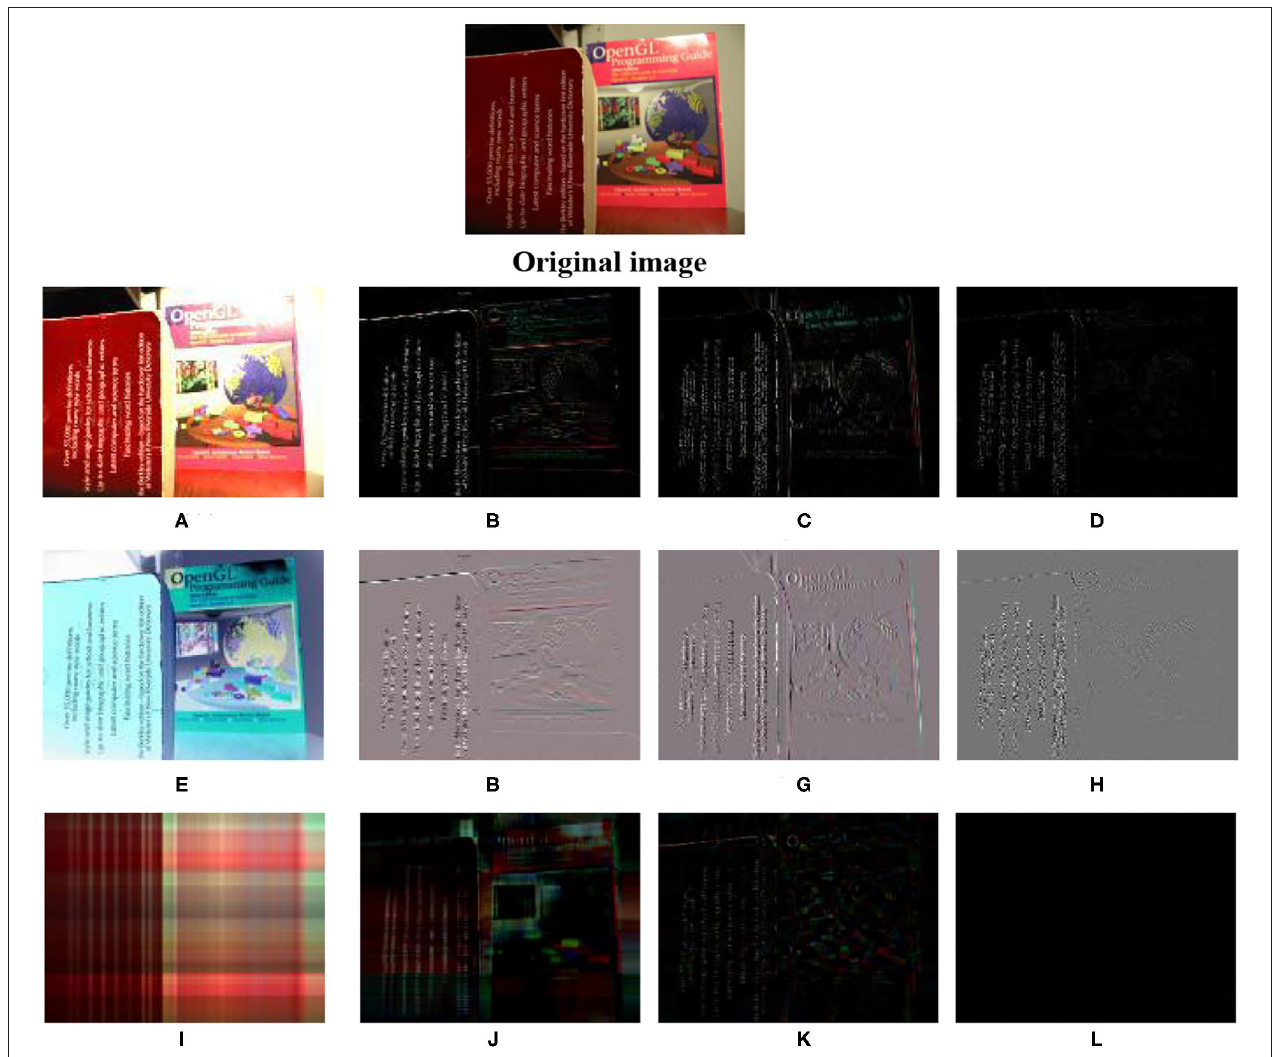
FIGURE 1 | This figure shows the decomposition of color image by QMSVD, MSVD, and QSVD. (A) The low-frequency image of the origianl image after decomposed by QMSVD, and (B–D) the high-frequency images of the origianl image. (E) The low-frequency image of the original image after decomposed by MSVD, and (F–H) the high-frequency images of the original image. (I) The decomposition image corresponding to the first eigenvalue of the original image decomposed by QSVD, and (J) the decomposition image corresponding to the eigenvalue truncated from the 2th to the 25th after QSVD decomposition, (K) the decomposition image corresponding to the eigenvalue truncated from the 26th to the 50th, (L) the decomposition image corresponding to the eigenvalue truncated from the 51th to the 240th. The eigenvalues are arranged from large to small.